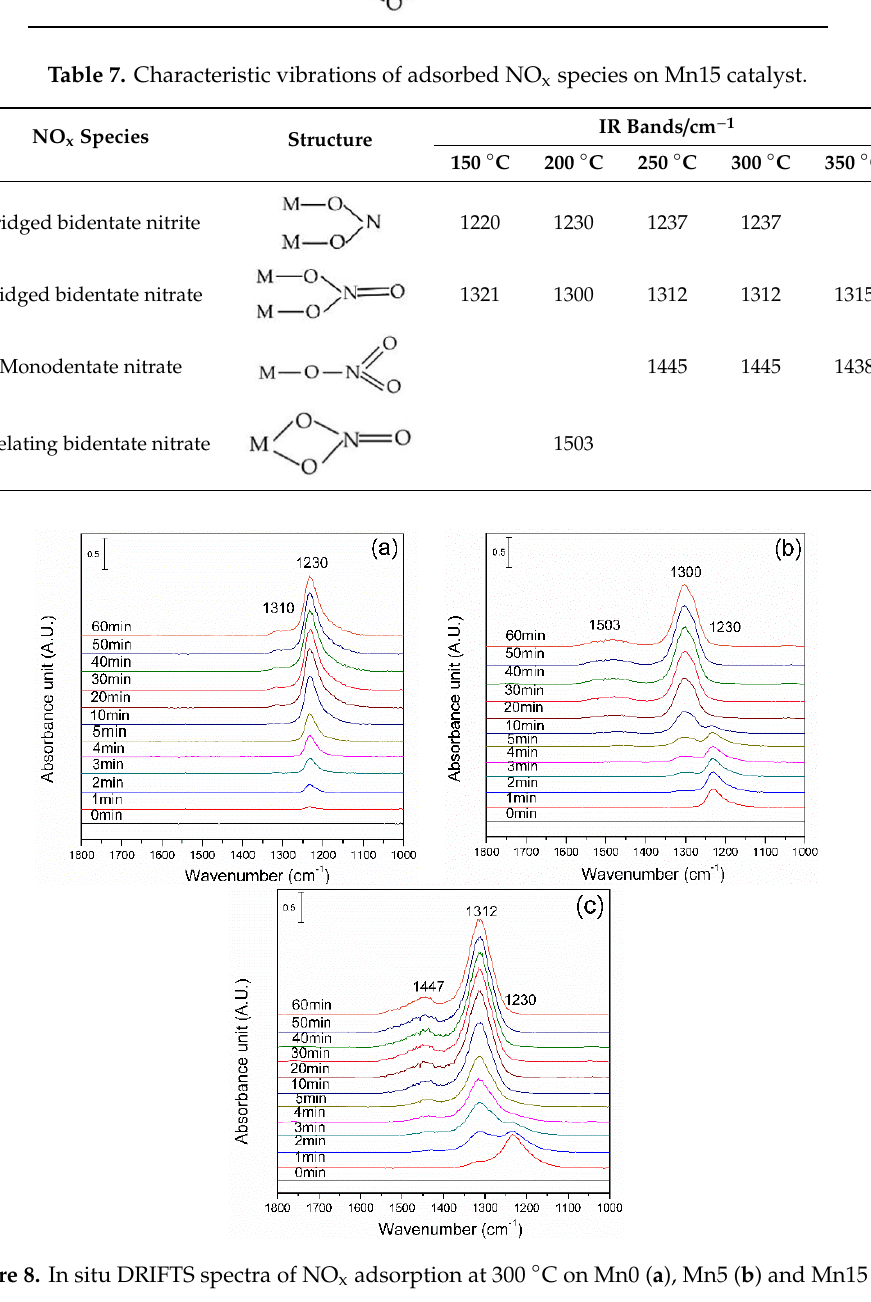
Figure 8. In situ DRIFTS spectra of NO x adsorption at 300 °C on Mn0 ( a ), Mn5 ( b ) and Mn15 ( c ).